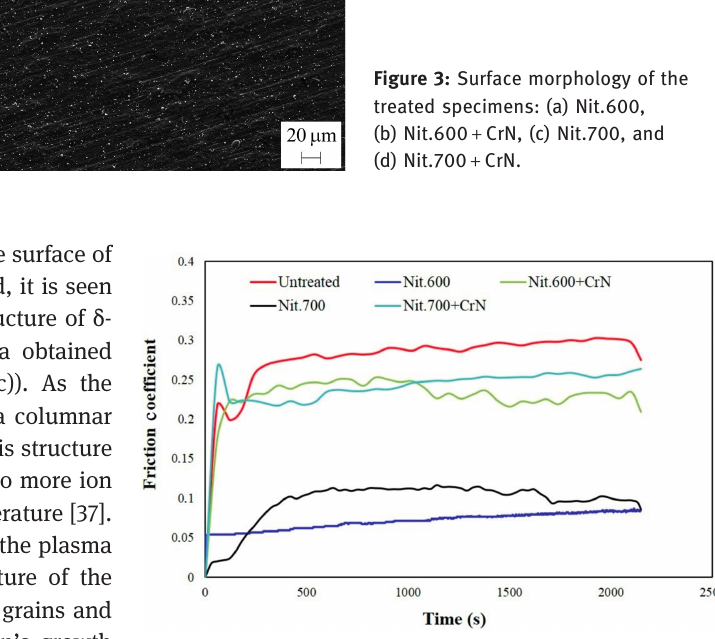
Figure 4: Friction test results of the untreated, plasma nitrided, and duplex-treated pure titanium